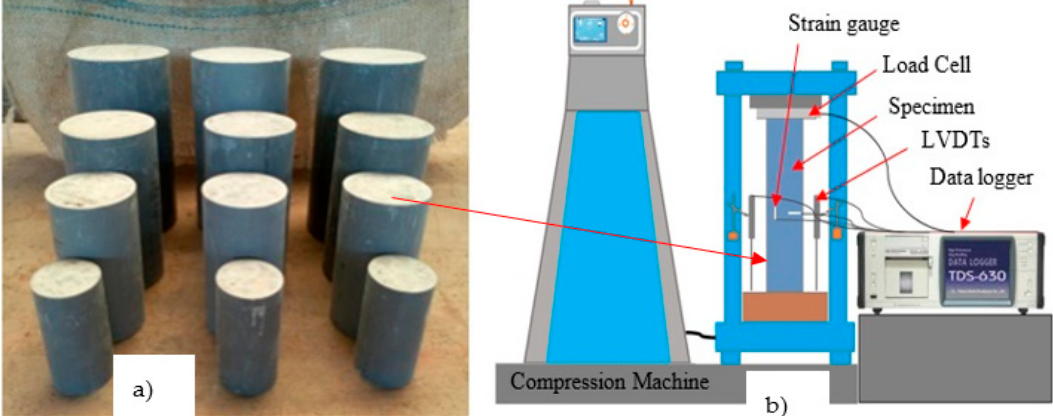
Figure 6. ( a ) uPVC confined concrete cylinders; ( b ) Test setup.